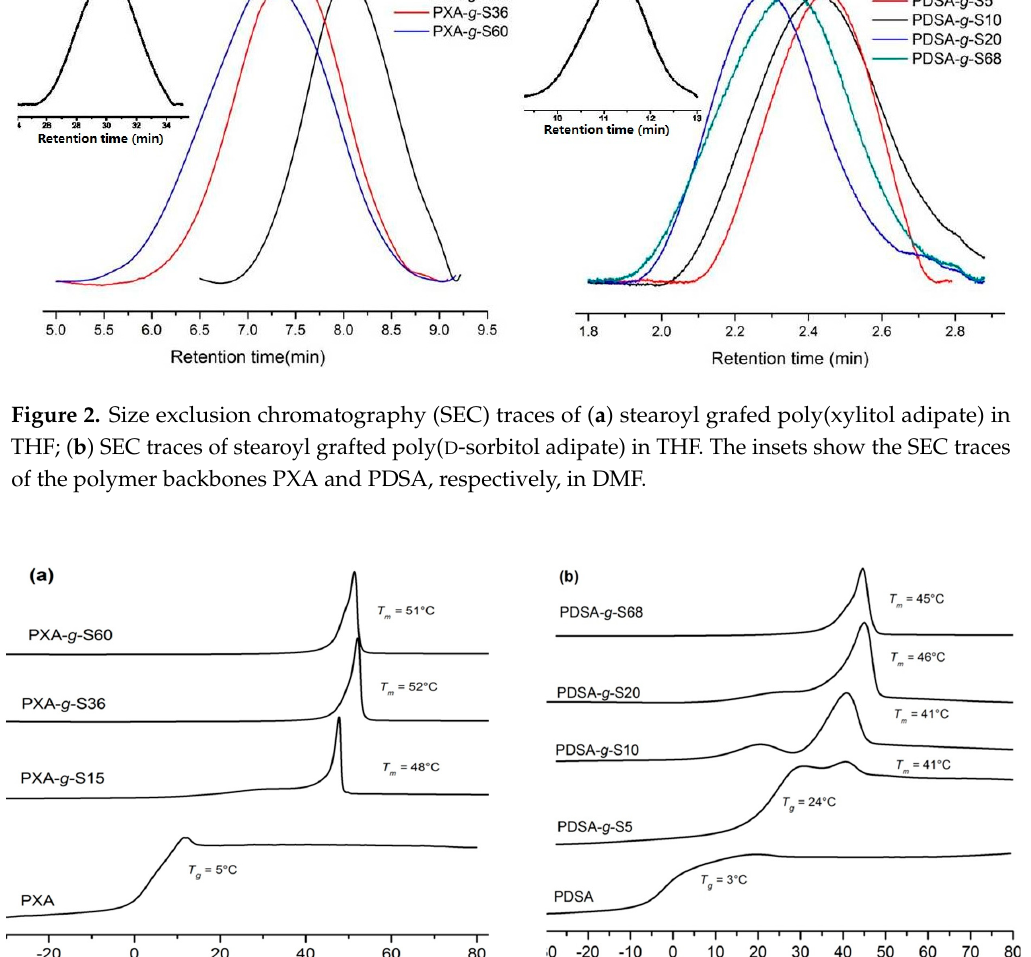
Figure. 3. DSC traces of ( a ) grafted and non-grafted PXA and ( b ) grafted and non-grafted PDSA. The measurements are carried out with a heating rate of 10 K·min − 1 . measurements are carried out with a heating rate of 10 K ¨ min ´ 1